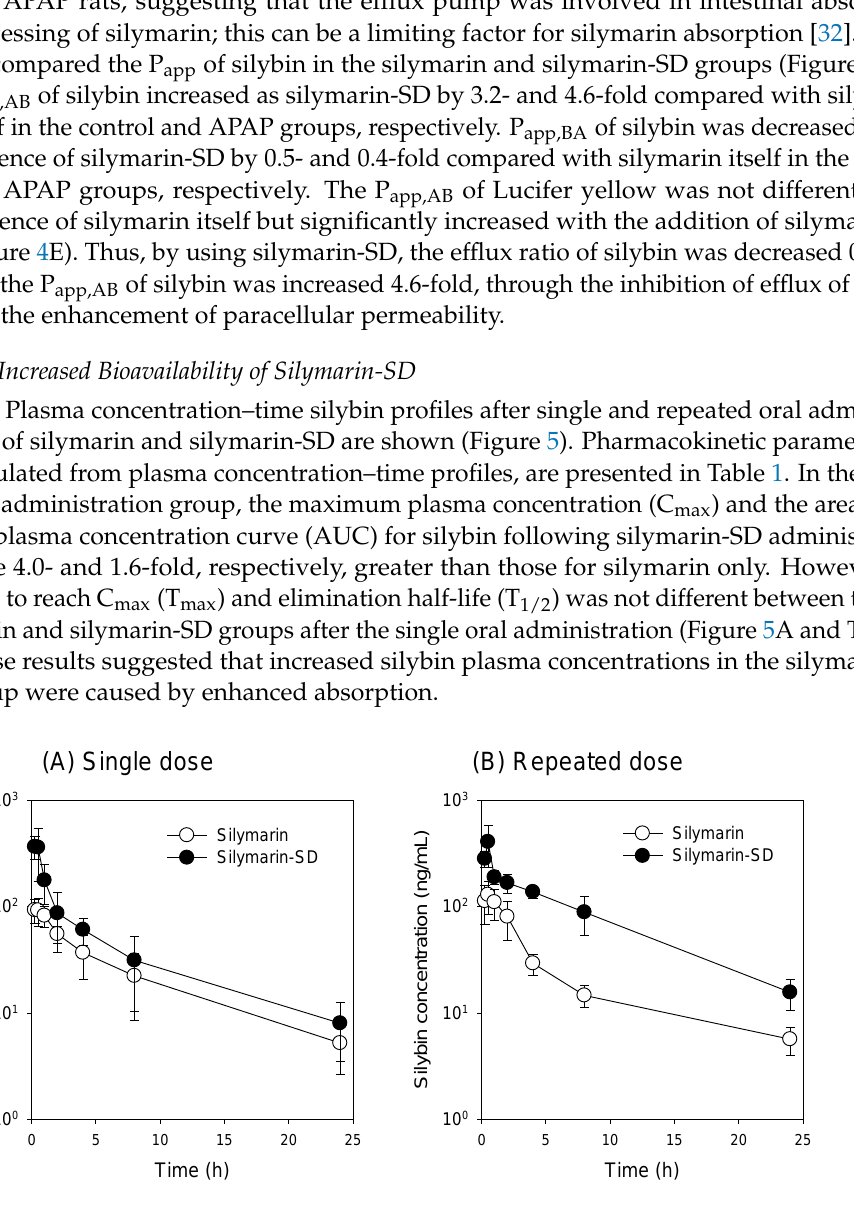
Figure 5. Plasma concentration – time profiles of silybin after ( A ) single and ( B ) repeated oral administration for five consecutive days of silymarin (20 mg/kg as silybin) and silymarin-SD (20 mg/kg as silybin) in rats with APAP-induced hepatotoxicity. Treatments followed the dosing schedule (Figure 1). Each data point represents the mean ± standard deviation of four rats per group. Table 1. Pharmacokinetic parameters of silybin .